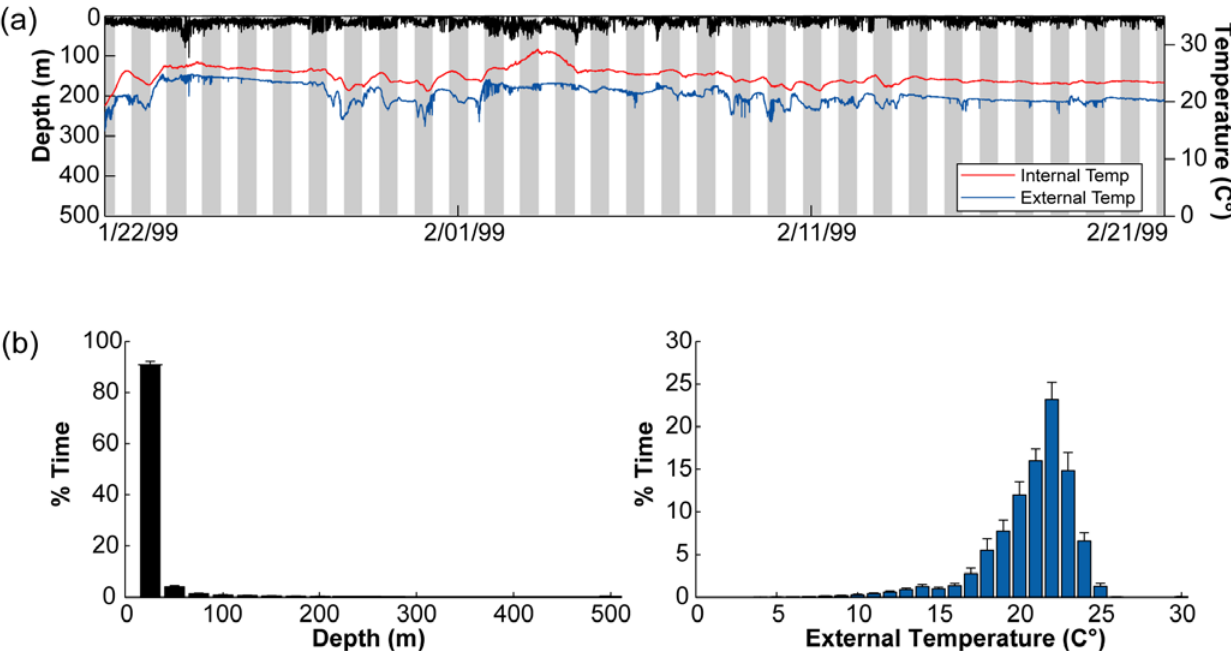
Figure 7. Typical diving behavior, external and internal temperature in the high use area of North Carolina. (a) One month of a typical diving behavior (black) profile displayed with external (blue) and internal temperature (red) (WC98-485). Grey shades indicate nighttimes obtained through light level data. (b) Overall depth (left,black histogram) and ambient temperature (right, blue histogram) preferences in the high use area of North Carolina (1997–2005; n=50).